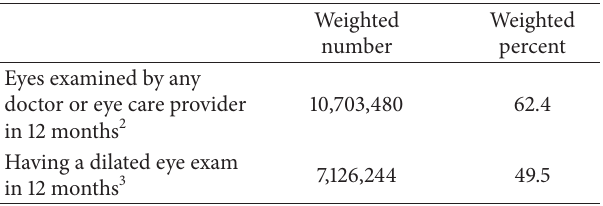
Table 2: Weighted number and percentage of adults aged 40 and over utilizing eye care services in 11 states in 2008–2010, BRFSS 1 .